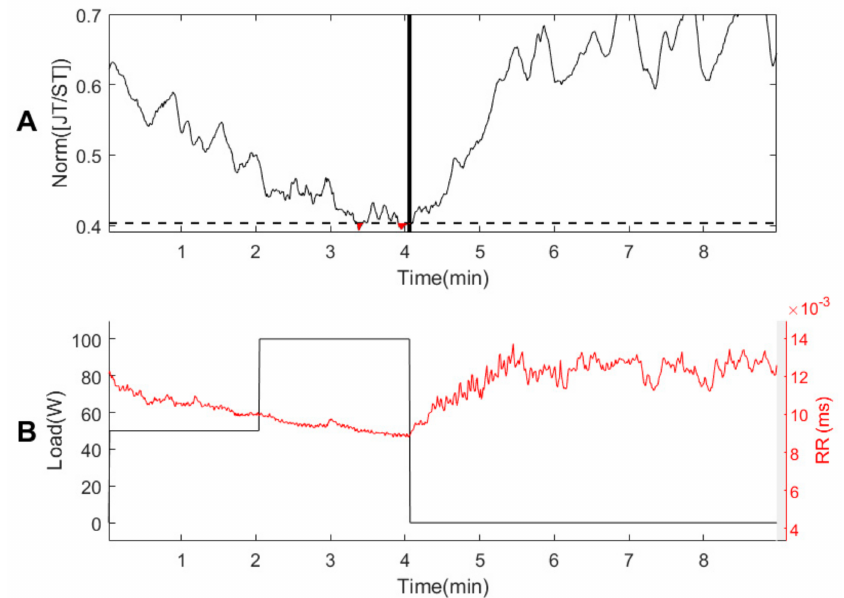
Figure 10. The dynamics of the JT/ST relationship during the load and recovery processes for person #9. The x -axis in parts ( A , B ) represents the time (measured in minutes) from the beginning of the cycle ergometry exercise. The left y-axis in part ( B ) represents the power of the load in Watts. The right y-axis in part ( B ) represents the variation of the RR interval in ms. The algebraic JT/ST relationship is represented by the thin dashed black line in part A. The thick black solid vertical line in part A marks the end of the